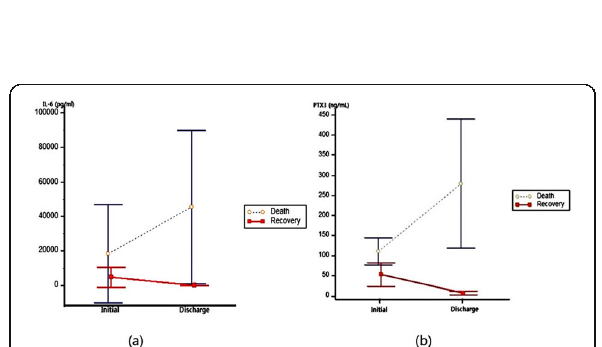
Fig. 4 (abstract P14). Error Bars of Initial (within 6 hours of Clinical Diagnosis) and Follow-up (within 24 hours of Discharge) Levels of Interleukin-6 (a) and Pentraxin-3 (b) in Septic Shock Patients who Died or Recovered during